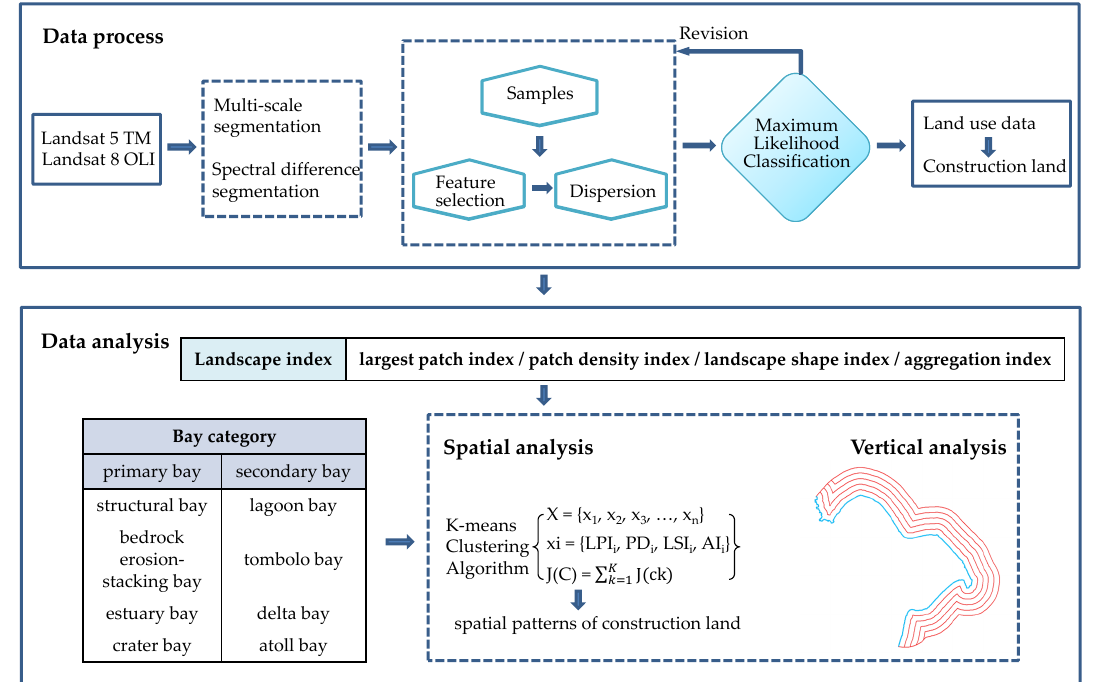
Figure 2. Research diagram